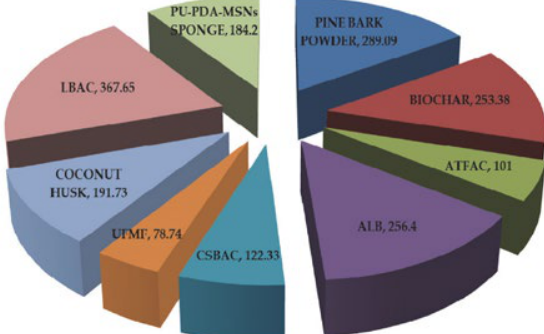
Figure 8. Comparison of maximum monolayer adsorption capacities of various Adsorbents for 2,4,6-TCP. [Acid treated coconut fiber acti- vated carbon (ATFAC); Acacia leucocephala bark (ALB); Coconut shell-based activated carbon (CSBAC); Urea-formaldehyde macrop- orous foams (UFMF); Loosestrife-based activated carbon